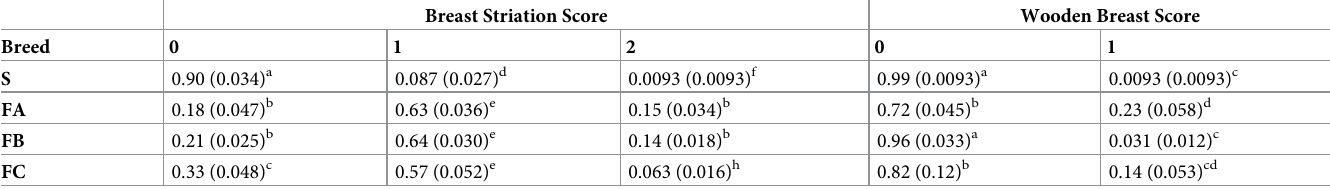
Different letters denote signicant differences (P <